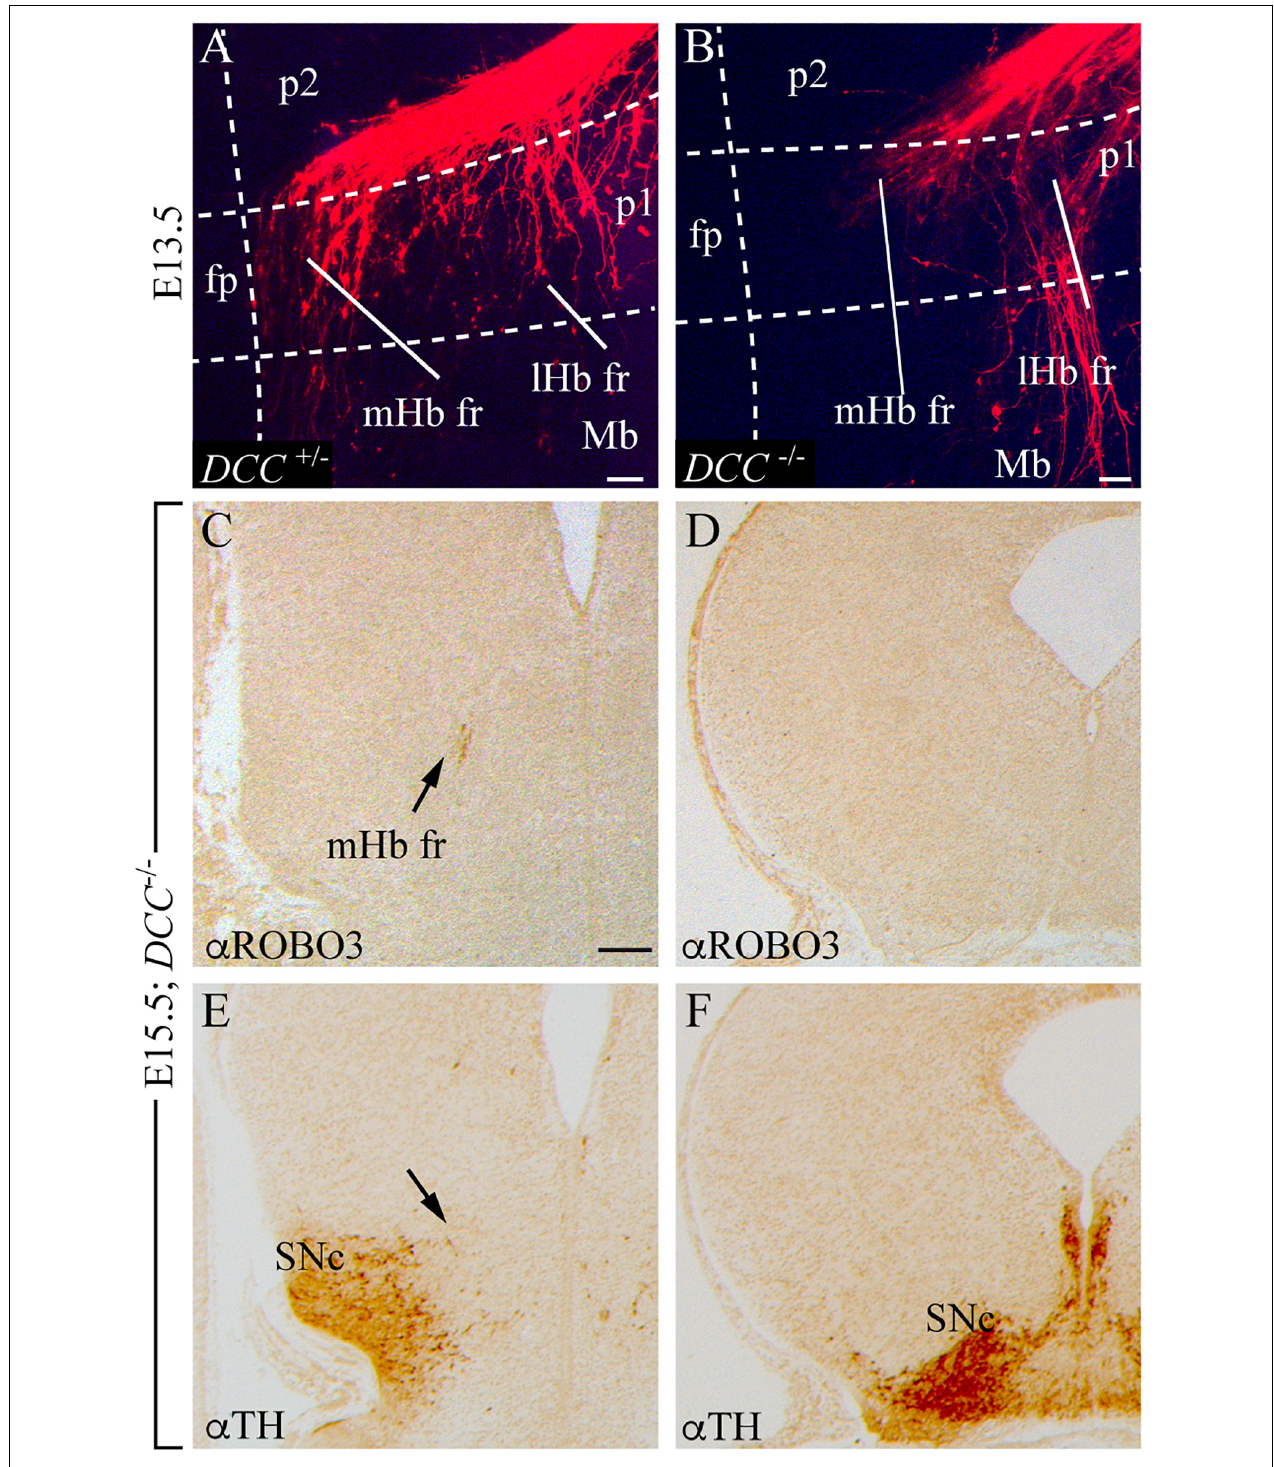
FIGURE 8 | The fr phenotype in DCC mutant. (A,B) Top view of E13.5 ONTs of DCC + / − (A) and DCC − / − (B) mutant embryos labeled with DiI in the Hb. The white dotted lines define the boundaries between different neuromeres (p2, p1, and Mb). The floor plate is on the left and caudal to the bottom. (C–F) Adjacent coronal paraffin sections of an E15.5 DCC − / − specimen at comparable section levels. IHC against ROBO3 (E,F) and TH (G,H) . The arrows in (C,E) show the localization of the fr in a DCC − / − mutant. Abbreviations: fp, floor plate; lHb fr, lateral habenular axons of the fasciculus retroflexus; Mb, midbrain; mHb fr, medial habenular axons of the fasciculus retroflexus; mtg, mammillotegmental tract; p1, prosomere 1 (pretectum); p2, prosomere 2 (thalamus); SNc, substantia nigra pars compacta. Scale bar: 50 µ m in (A,B) and 200 µ m in C–F .